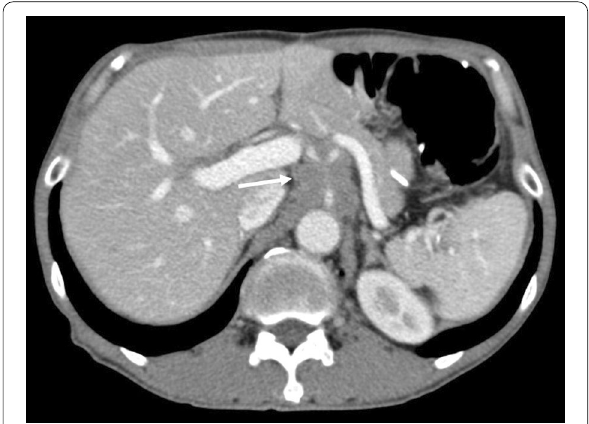
Fig. 1 Computed tomography revealed a swollen lymph node (35 mm 33 mm) in station no. 9 along the celiac artery (arrow) ×